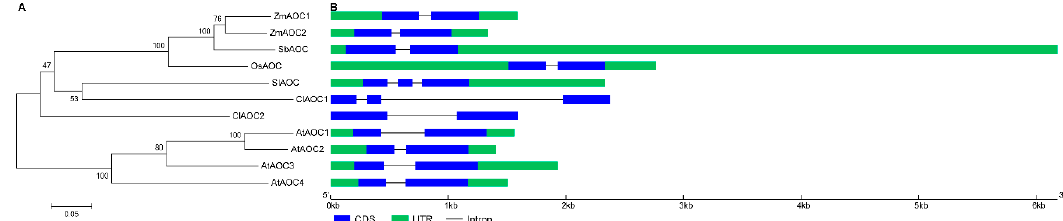
Figure 4. The gene structures of AOC family genes from different plant species ( B ) based on the phylogenetic relationship ( A ). The green boxes, blue boxes, and black lines indicate UTRs, CDSs, and introns, respectively.